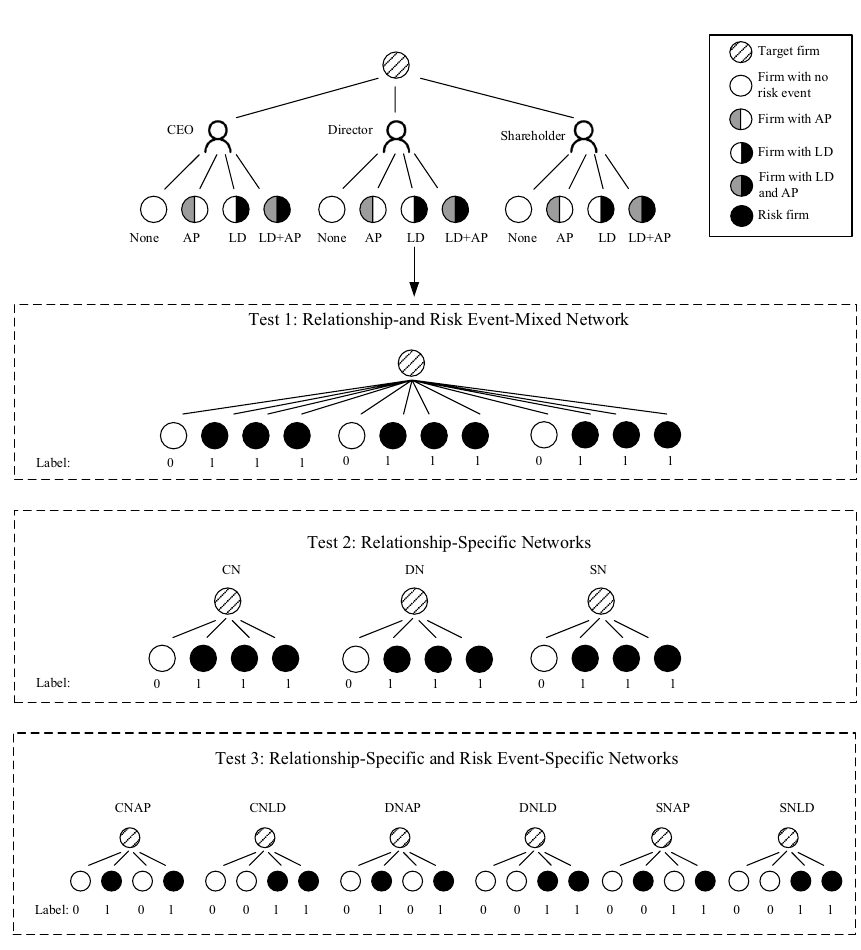
Fig. 4 Tests design for examining research